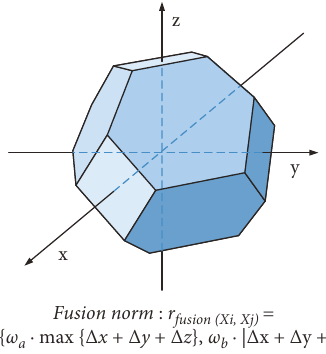
Figure 4: Search domain function and geometric mapping of the fused